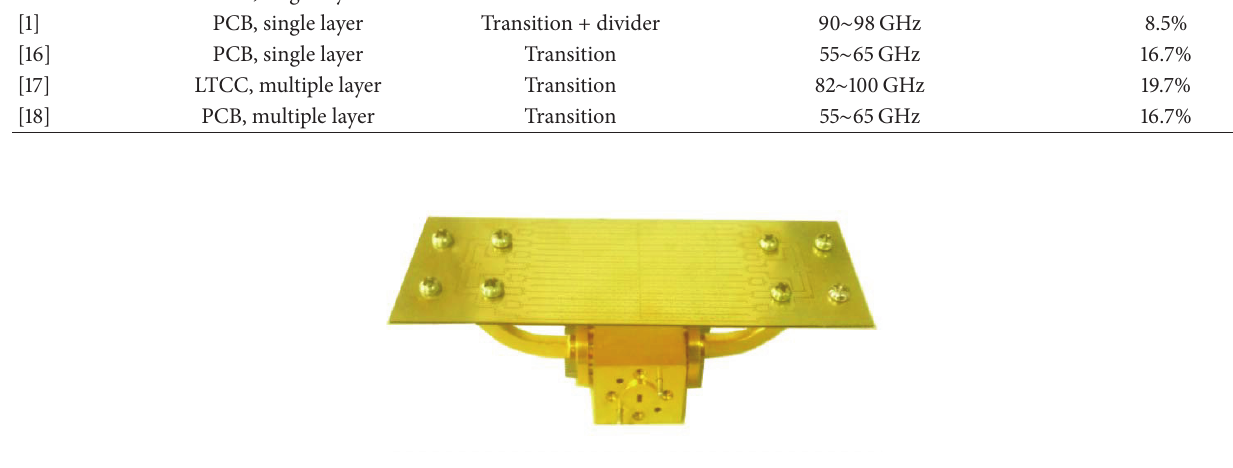
Figure 9: Photograph of the fabricated antenna.